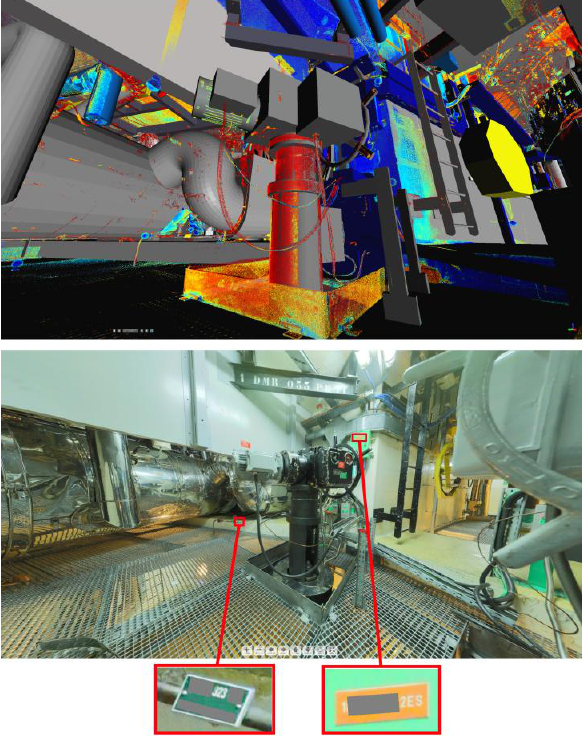
Figure 7: sample data from the wide multi-sensor as-built acquisition campaign. Top : part of the 3D CAD as-built model with point cloud used for reconstruction. Down : High-resolution panoramic image (340 MPixels) of the same viewport. Bottom: details of the panoramic visible by zooming on the image: many labels are still readable form few meters